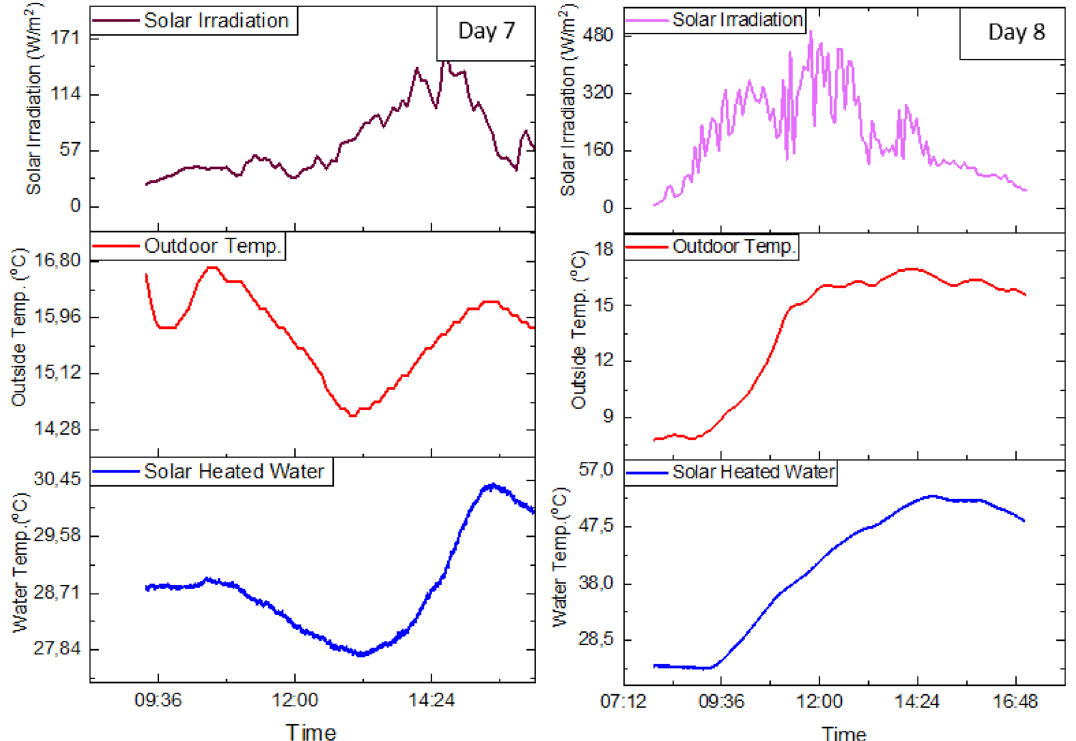
Fig. 7 Solar irradiation, outdoor temperature and solar heated water temperature for day 7 and day 8